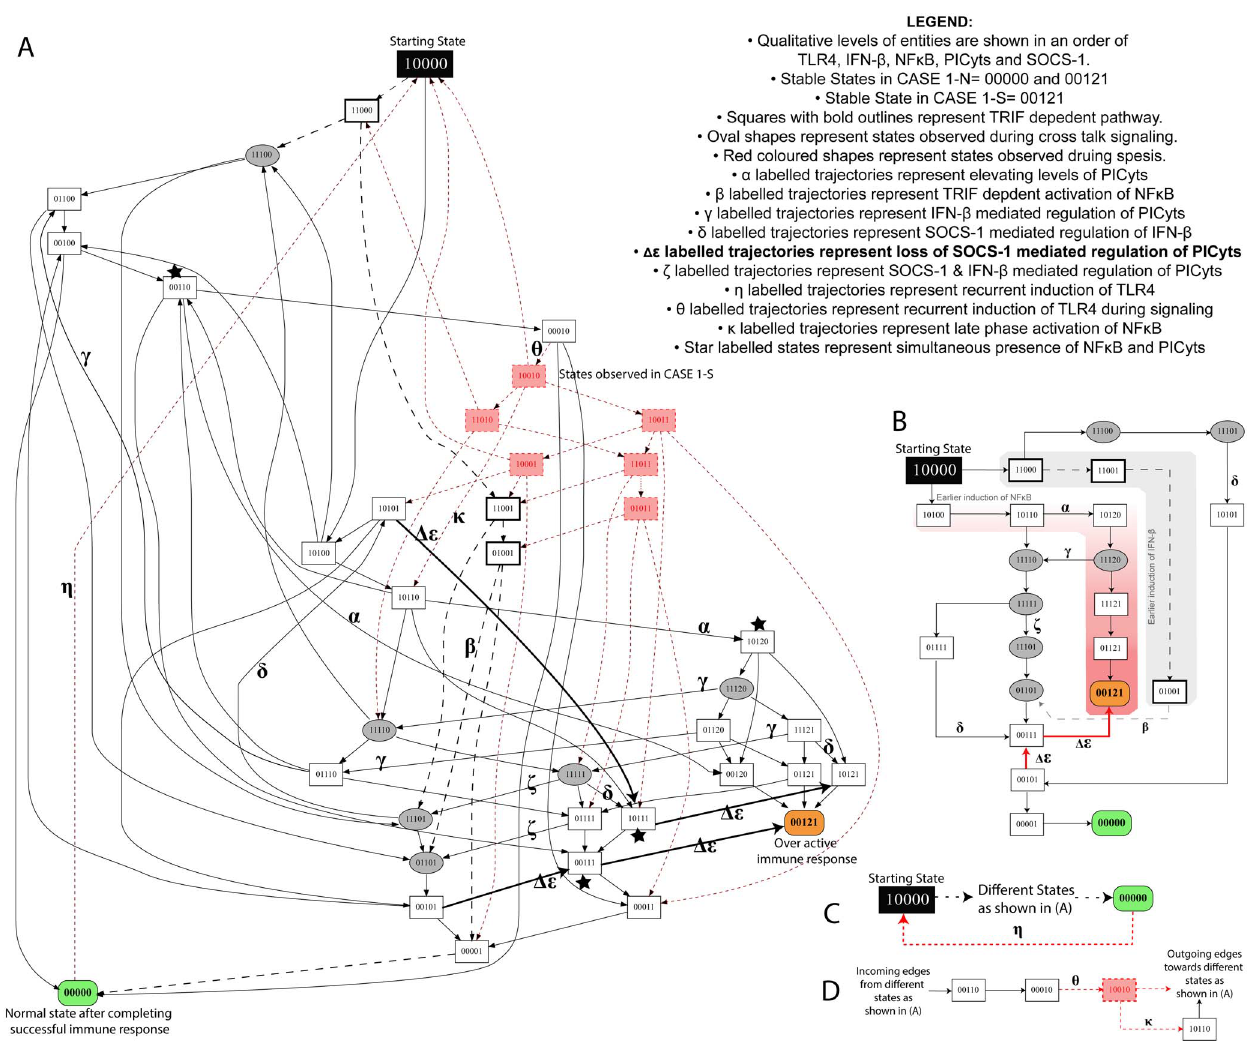
Figure 4. State graph of CASE 1-N and 1-S. (A) Each node represents a particular state observed during signalling associated with CASE 1-N and CASE 1-S. Integers ‘‘0’’, ‘‘1’’ and ‘‘2’’ within the nodes represent qualitative levels of proteins in the order of TLR4, IFN- b , NF k B, PICyts and SOCS-1. Inactive entities are represented by integer ‘‘0’’ whereas active and overactive entities are represented by integers ‘‘1’’ and ‘‘2’’, respectively. States and trajectories, which were specifically observed during signalling dynamics associated with CASE 1-S, are shown in red, whereas common states and trajectories found in both CASES are shown in black. Trajectories start from state ‘‘10000’’, representing the activation of TLR4 and ultimately lead towards ‘‘00000’’ and ‘‘00121’’, which are stable states in CASE 1-N. On the other hand, only one stable state ‘‘00121’’ was observed during signalling dynamics associated with CASE 1-S and a trajectory labelled with ‘‘ g ’’ from state ‘‘00000’’ to starting state ‘‘10000’’ results in cyclic path. Trajectories associated with loss of SOCS-1 mediated downregulation of PICyts in CASE 1-N and CASE 1-S are presented as bold arrows labelled with symbol ‘‘ De ’’. Nodes are labelled with stars in which NF k B and PICyts were active simultaneously and have the probability to lead towards overactive immune response. MyD88 and TRIF dependent signalling are shown as black lines and dashed arrows, respectively. Nodes, which represent crosstalk of both signalling pathways i.e. IFN- b and NF k B with qualitative level ‘‘1’’ are presented in oval shapes. Arrows labelled with Greek small letters are used to represent trajectories associated with different signalling events (see legend in the figure). The conditions necessary to produce a state graph are shown in the figure are given in Table 3. (B–D) specific states and trajectories which can possibly represent the complete state graph given in (A).